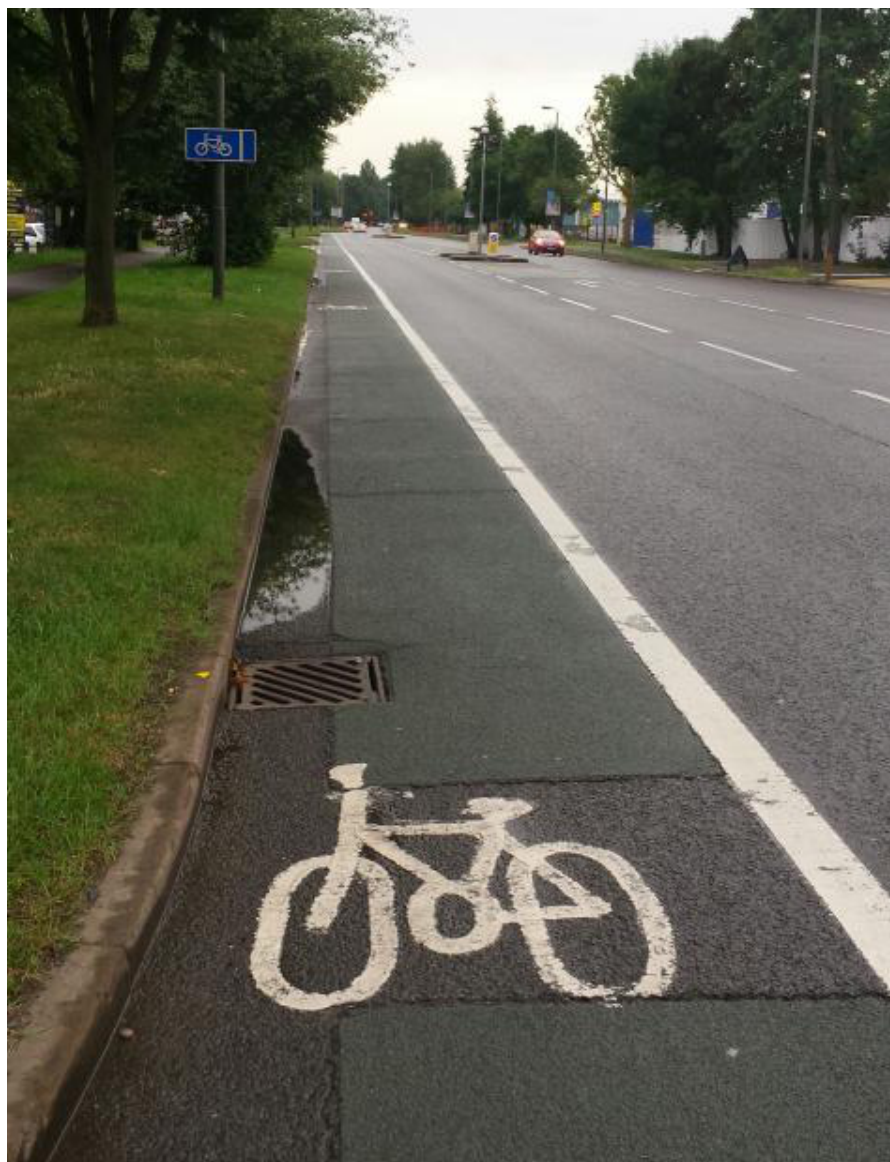
Figure Apx.6. Mandatory Cycle